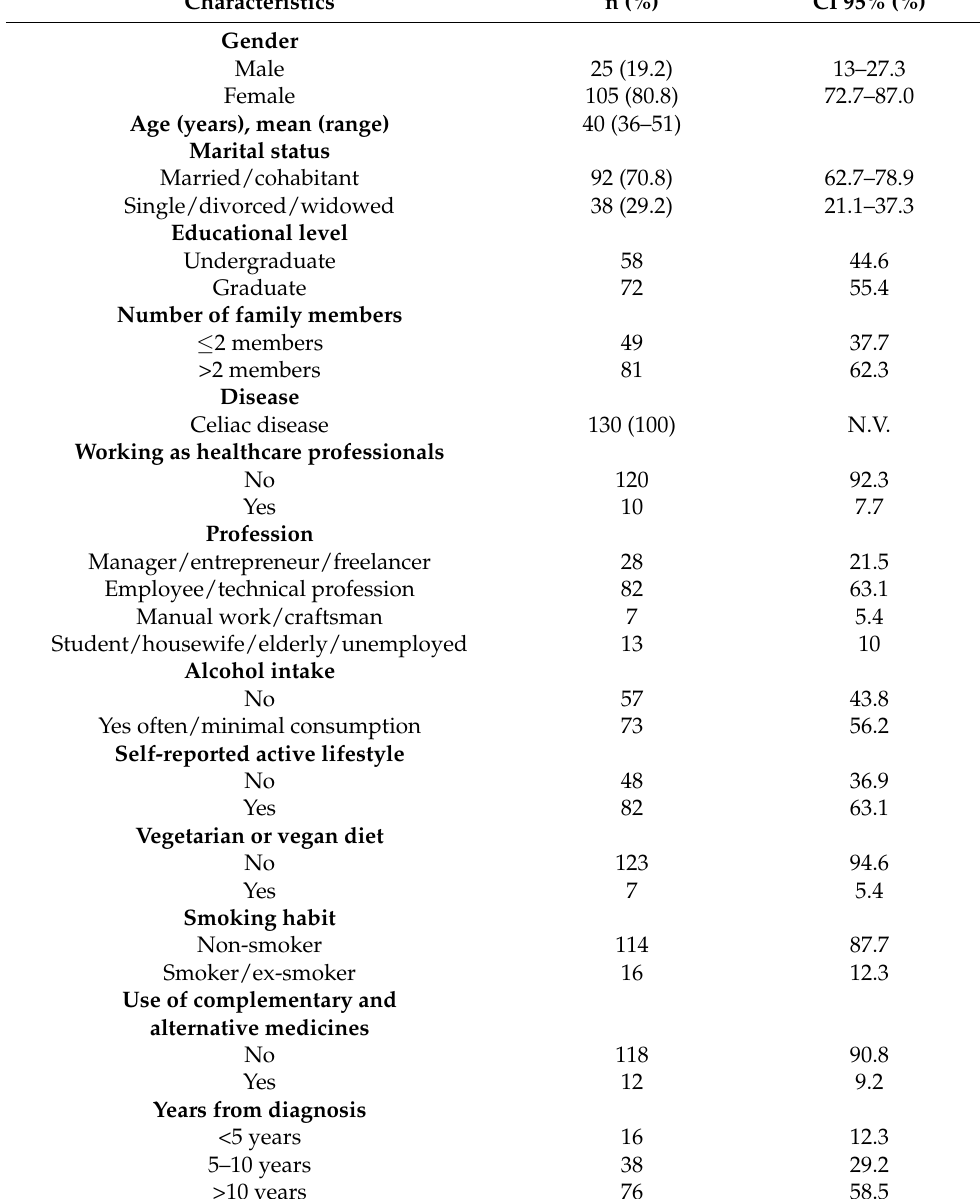
Table 2. Sociodemographic, occupational, and lifestyle characteristics of the study population (n =